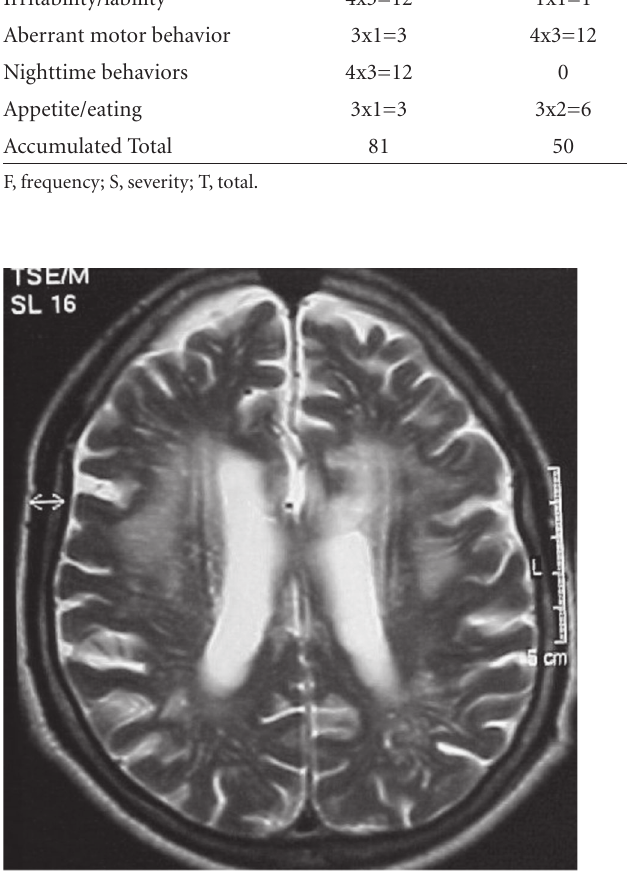
Figure 1. Case 1 – RM (T2 axial) showing multiple confl uent white matter lesions, not reaching the “U” fi